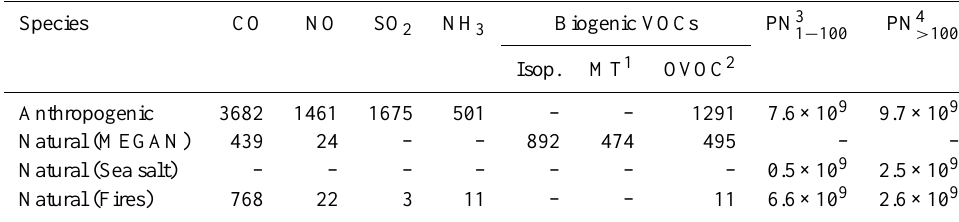
Table 1. Emission totals of gas-phase species (in ktonsmonth − 1 ) and particle number (in particles m − 2 h − 1 ) for the European domain during May 2008.